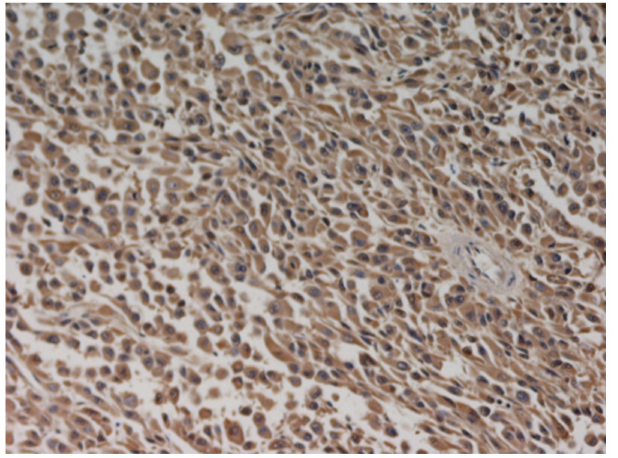
Figure 2. Immunohistochemical picture of S100 protein strongly positive melanoma metastasis (hematoxylin counterstain; 400 ×